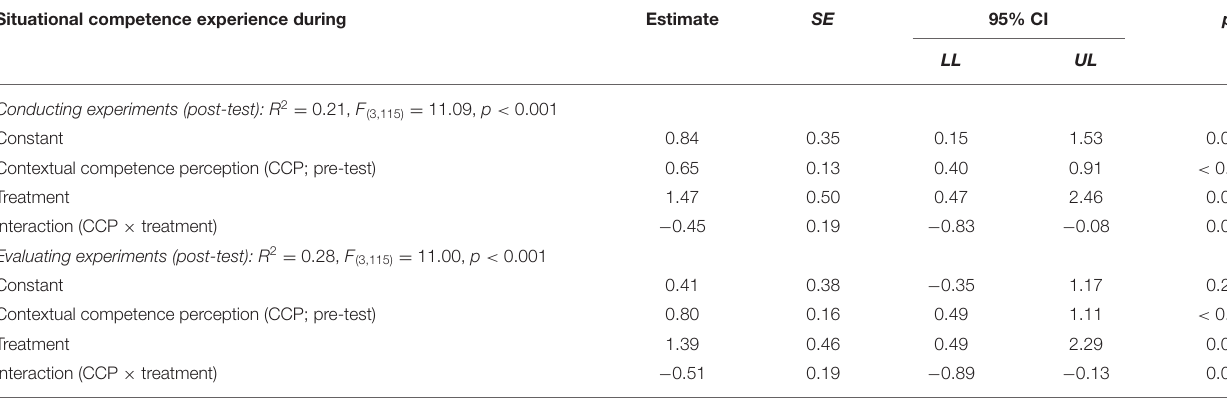
TABLE 3 | Results of the multiple linear regression analyses regarding conducting and evaluating experiments. Situational competence experience during Estimate SE 95% CI